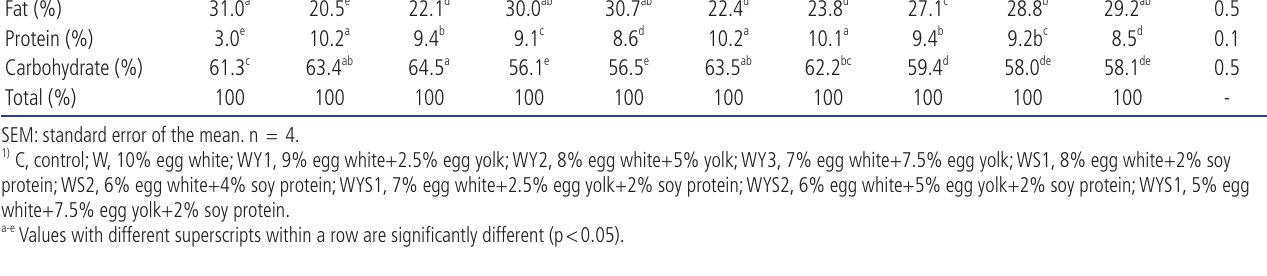
Table 3. The fatty acid composition of non-dairy creamers with different formula Fatty